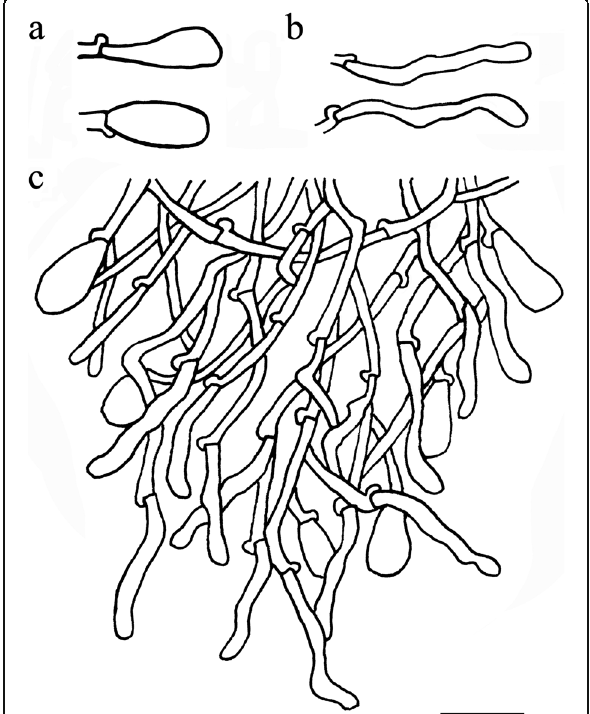
Fig. 11 Microscopic structures of Skvortzovia qilianensis (drawn from holotype). a basidioles. b leptocystidia. c apical part of a tooth. Scale bar = 10 μ